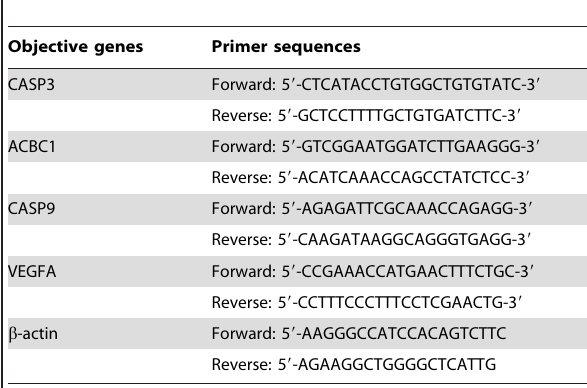
Table 1. Primers used for RT-qPCR